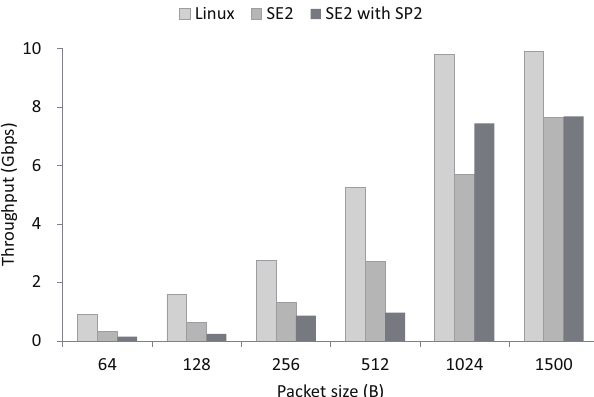
Figure 6. SP2 minimizes the performance overhead of SE2 from adopting VM abstraction, which achieves 80% of native performance with packets larger than 1024 bytes.